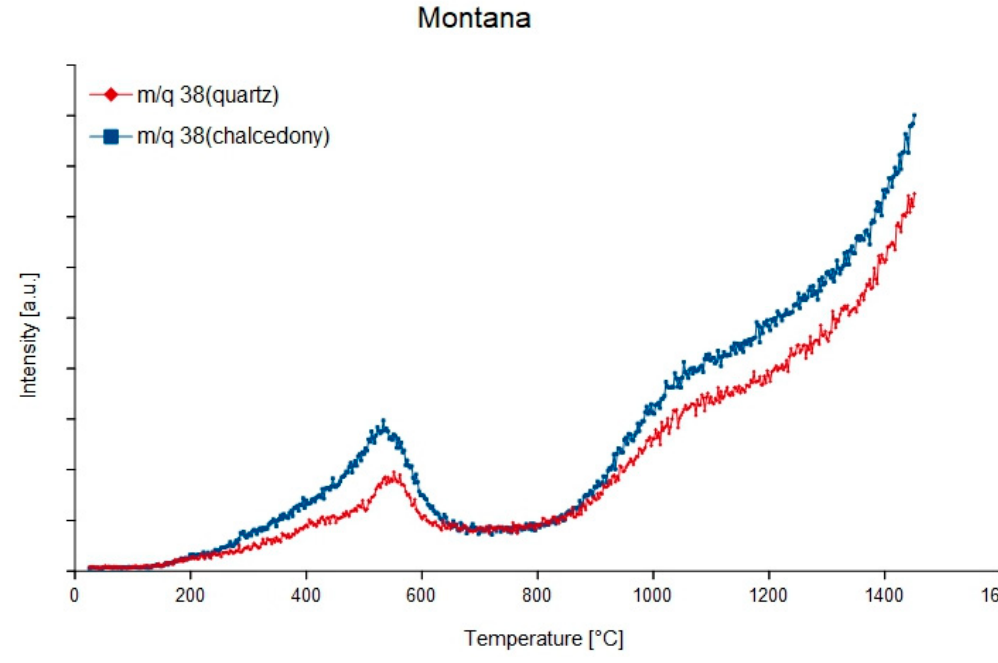
Figure 5. Degassing curves of the mass-charge ratio 38 ( 1 H 37 Cl) of quartz and chalcedony in sedimentary agate from Montana, USA.